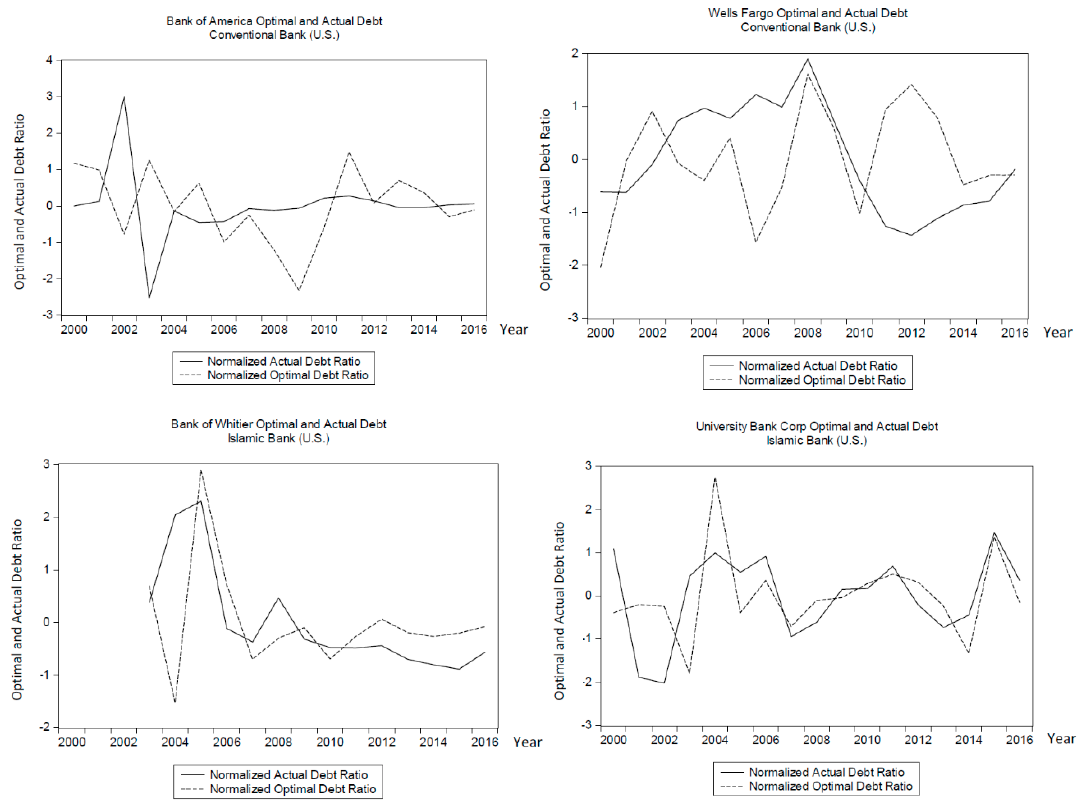
Figure 4. United States optimal- versus actual-debt ratio. Source: Author’s calculations.